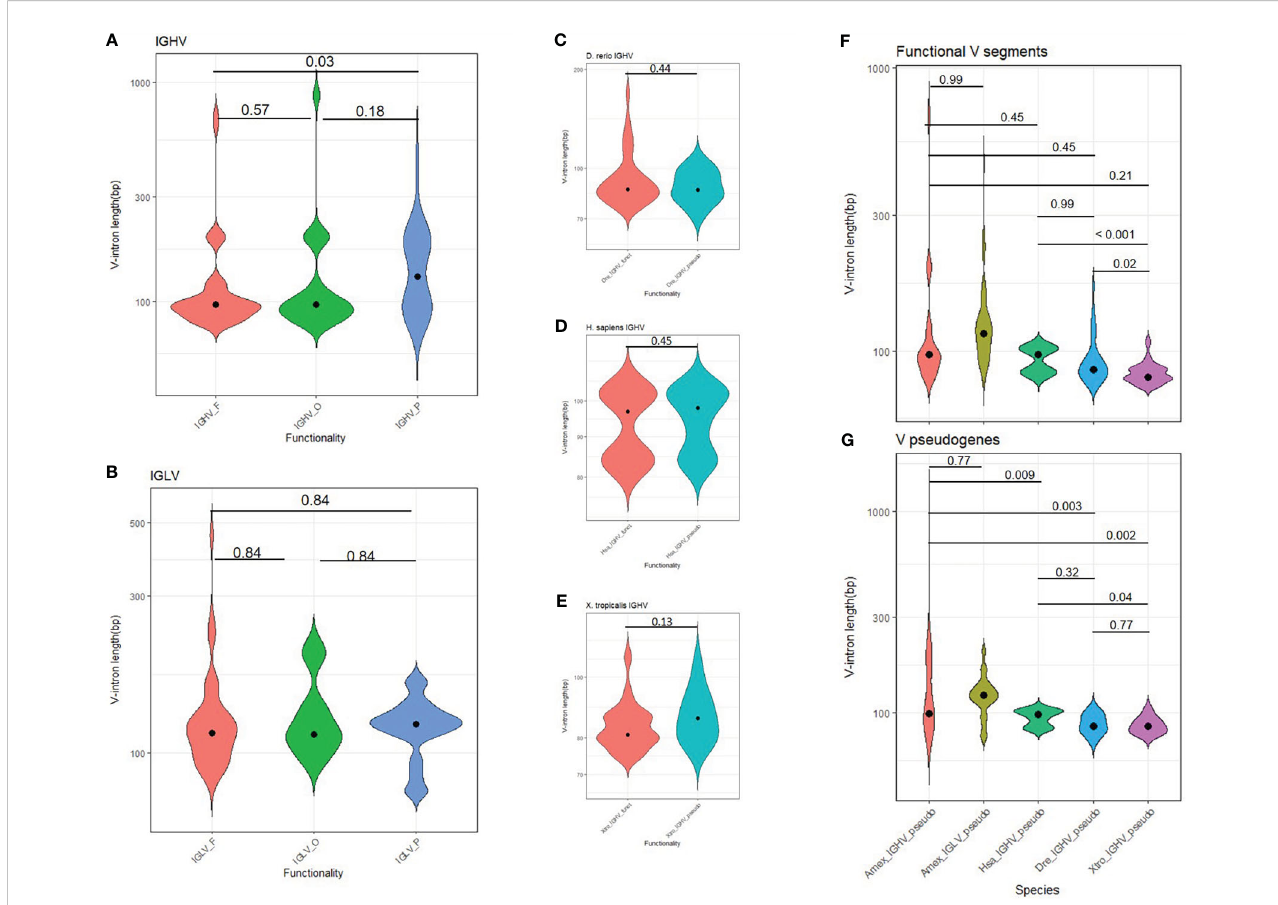
FIGURE 6 Distribution of V intron length in tetrapods. (A) The heavy chain and (B) lambda light chain locus in A. mexicanum according to their functionality class (functional, ORF or pseudogene). In A. mexicanum , intron length in functional IGHV genes was shorter than in IGHV pseudogenes. No differences were observed in the lambda locus and (C) D. rerio , (D) H. sapiens , and (E) X. tropicalis . V introns in functional IGHV A. mexicanum were not larger than functional A. mexicanum IGLV genes, or (F) functional IGHV of other tetrapods, however, V introns in (G) non-functional A. mexicanum IGHV genes were larger than other tetrapods. Statistical analysis for multiple comparisons (A, B, F, G) was performed with the robust ANOVA One-Way Trimmed Means Comparisons, with a trimming level of 5% (tr = 0.05), followed by the post hoc Lincon test (30). For two sample comparisons (C-F) , Yuen ’ s robust Tests for Two Independent Groups were performed with a trimming level of 5%. The violin area is scaled for comparability. The median is shown as a black